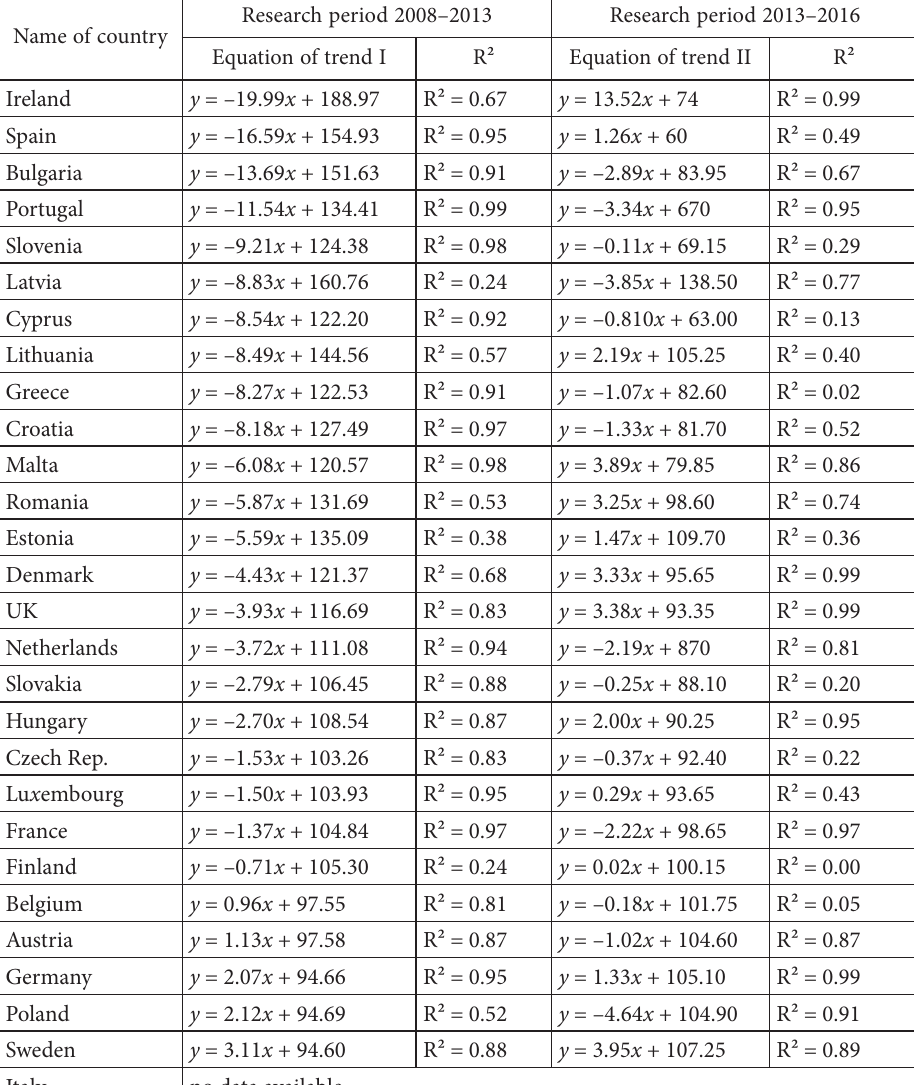
Table 5. Calculations pertaining to the employment in the building industry (source: author’s own